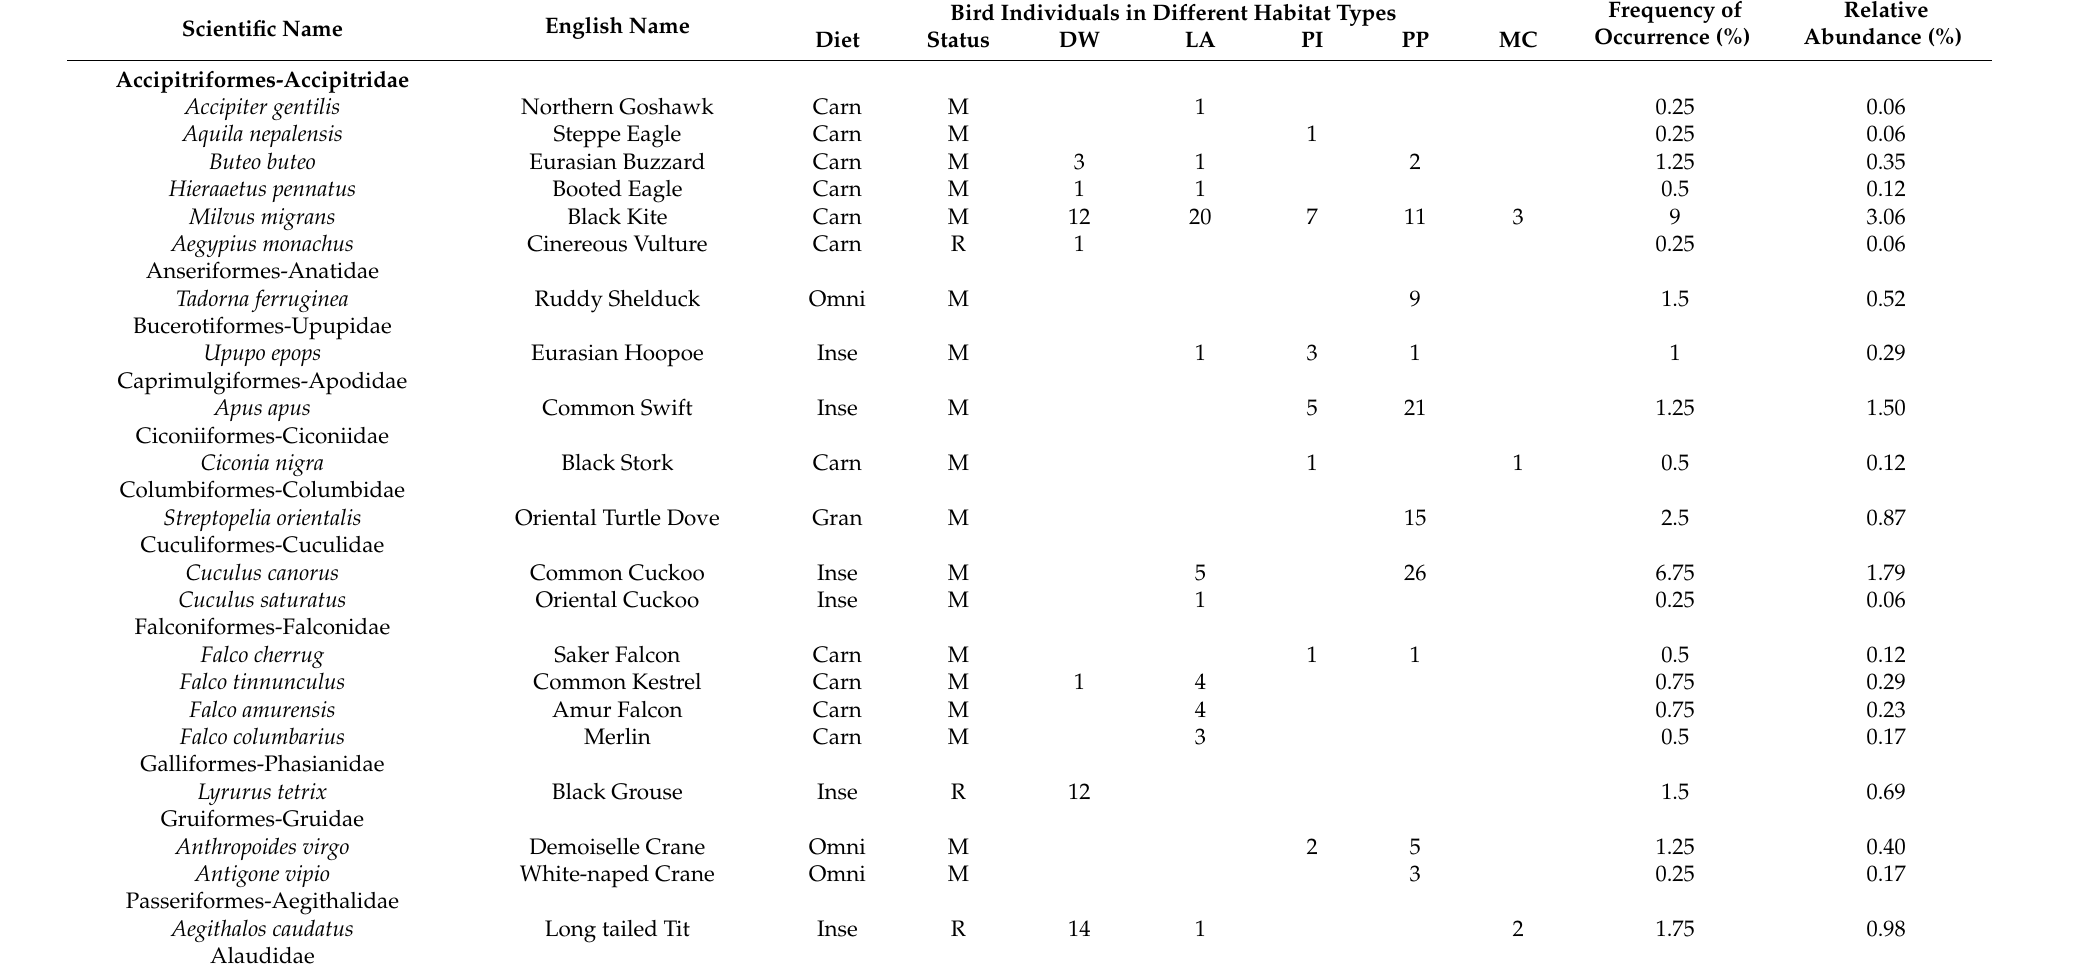
Table 1. List of bird species and their abundances and occurrences in different habitat types in the forest of the Khentii